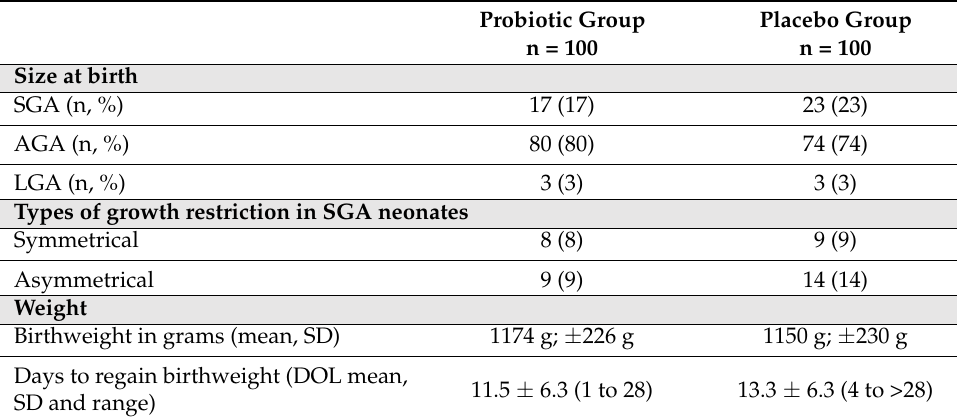
Table 3. Weight data of the neonates enrolled in the